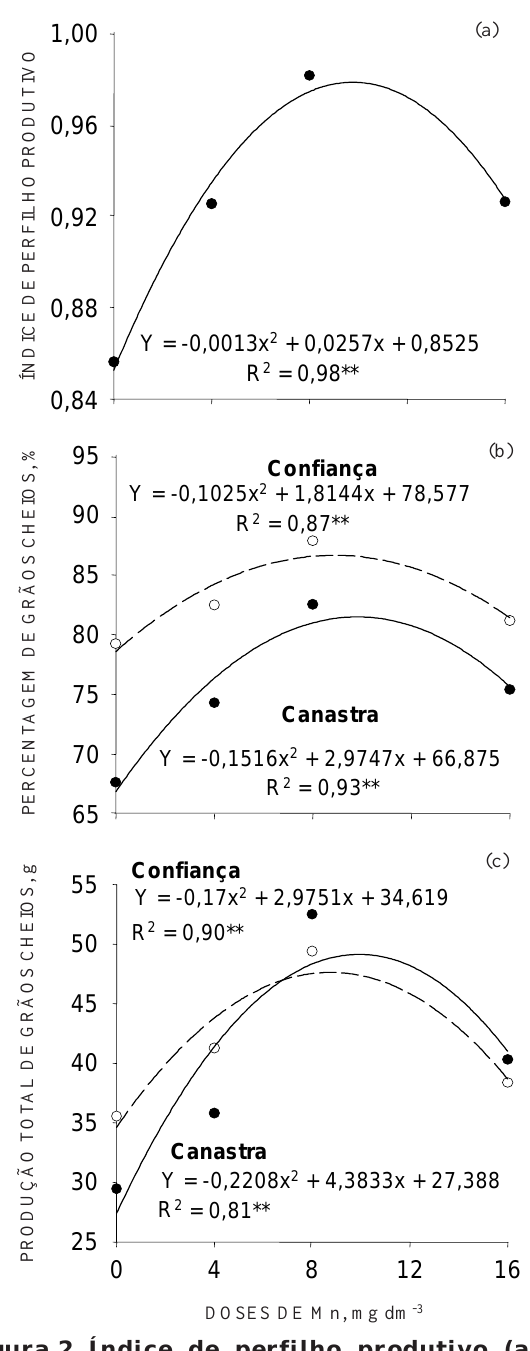
Figura 2. Índice de perfilho produtivo (a), percentagem de grãos cheios (b) e produção total de grãos cheios (c) nos cultivares estudados, considerando as doses de manganês aplicadas ao